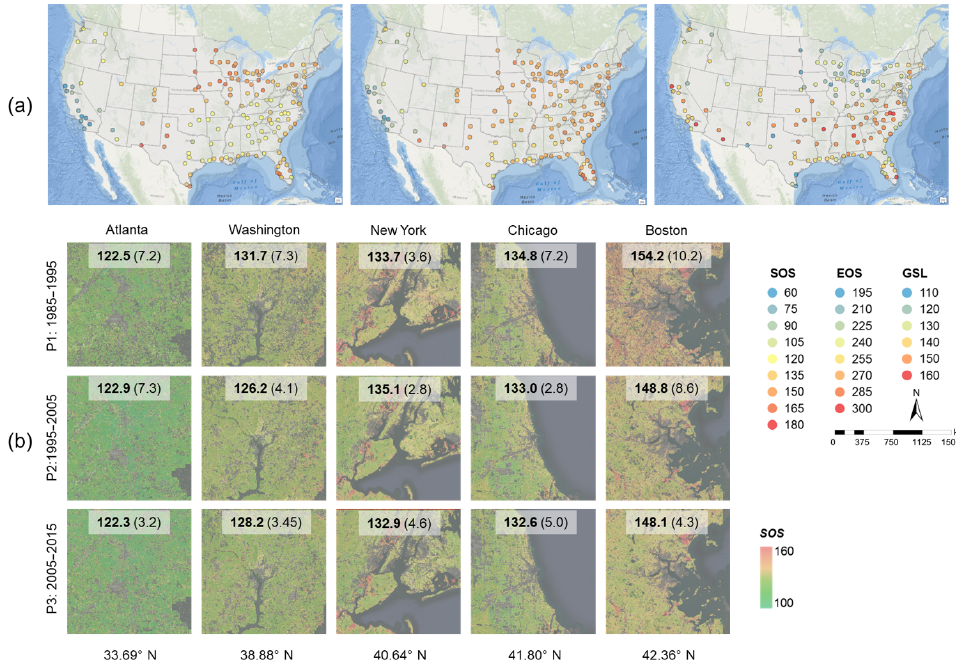
Figure 11. Spatial patterns of the mean (1985–2015) vegetation phenology indicators (start of season, SOS, end of season, EOS, and growth season length, GSL) in American cities (a) and SOS in representative cities over the past 3 decades (b) . Each dot in (a) represents the center of the urban cluster, and the spatial extent of selected cities in (b) is 25km × 25km. The mean SOS of each city and its standard deviation within each period (in parentheses) are provided in (b)